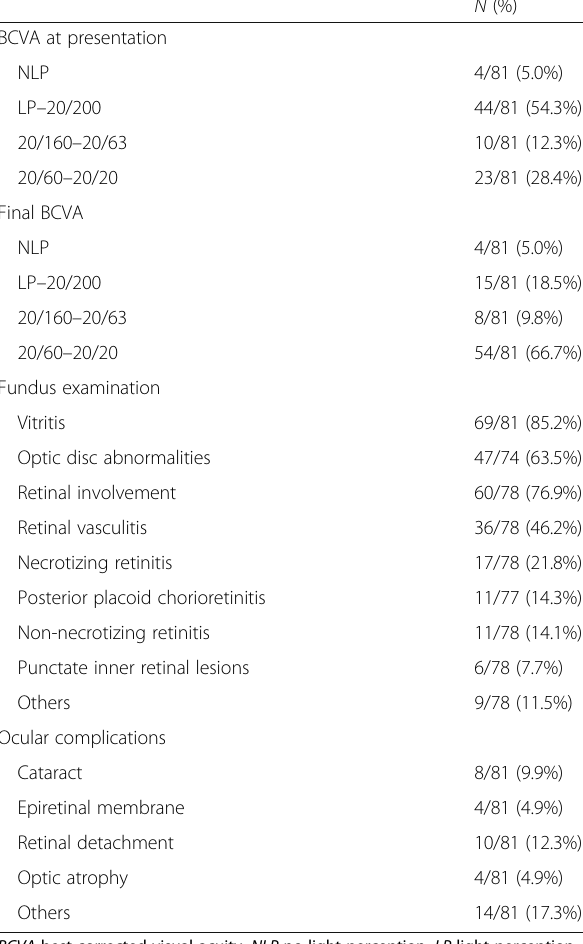
Table 1 Ocular features and complications in 81 eyes of 44 patients with syphilitic posterior uveitis